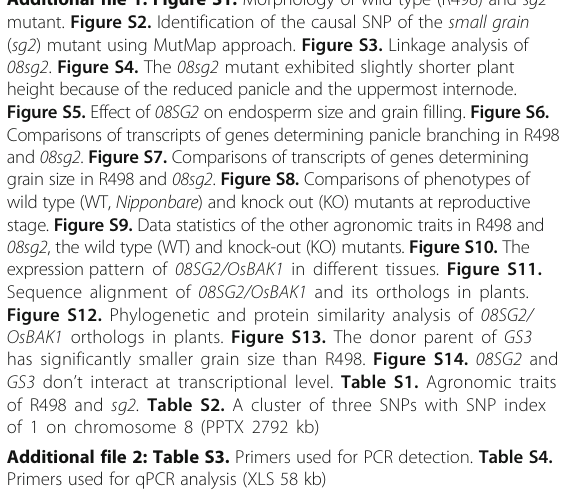
Additional file 1: Figure S1. Morphology of wild type (R498) and sg2 mutant. Figure S2. Identification of the causal SNP of the small grain ( sg2 ) mutant using MutMap approach. Figure S3. Linkage analysis of 08sg2 . Figure S4. The 08sg2 mutant exhibited slightly shorter plant height because of the reduced panicle and the uppermost internode. Figure S5. Effect of 08SG2 on endosperm size and grain filling. Figure S6. Comparisons of transcripts of genes determining panicle branching in R498 and 08sg2 . Figure S7. Comparisons of transcripts of genes determining grain size in R498 and 08sg2 . Figure S8. Comparisons of phenotypes of wild type (WT, Nipponbare ) and knock out (KO) mutants at reproductive stage. Figure S9. Data statistics of the other agronomic traits in R498 and 08sg2 , the wild type (WT) and knock-out (KO) mutants. Figure S10. The expression pattern of 08SG2/OsBAK1 in different tissues. Figure S11. Sequence alignment of 08SG2/OsBAK1 and its orthologs in plants. Figure S12. Phylogenetic and protein similarity analysis of 08SG2/ OsBAK1 orthologs in plants. Figure S13. The donor parent of GS3 has significantly smaller grain size than R498. Figure S14. 08SG2 and GS3 don ’ t interact at transcriptional level. Table S1. Agronomic traits of R498 and sg2. Table S2. A cluster of three SNPs with SNP index of 1 on chromosome 8 (PPTX 2792 kb) Additional file 2: Table S3. Primers used for PCR detection. Table S4. Primers used for qPCR analysis (XLS 58